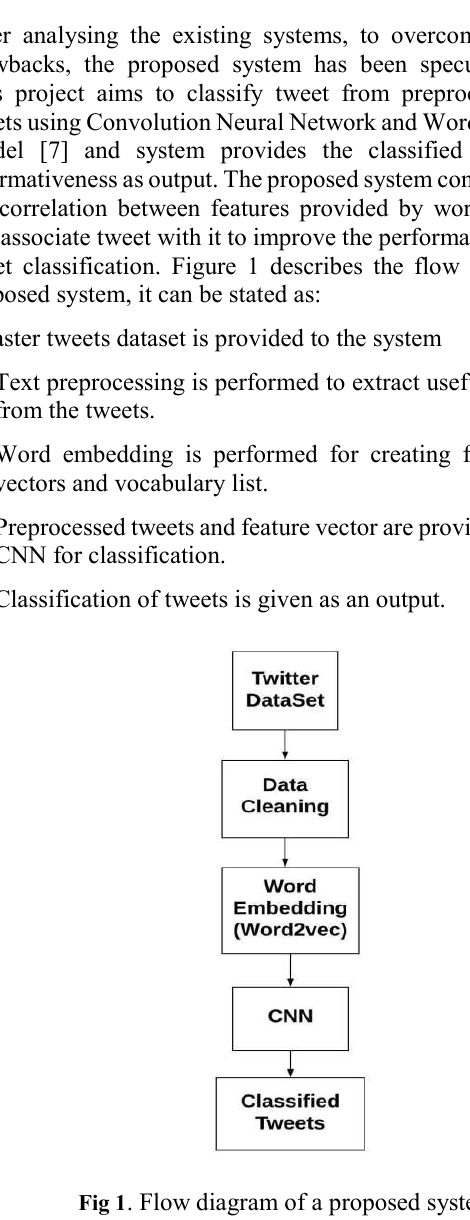
Fig 1 . Flow diagram of a proposed